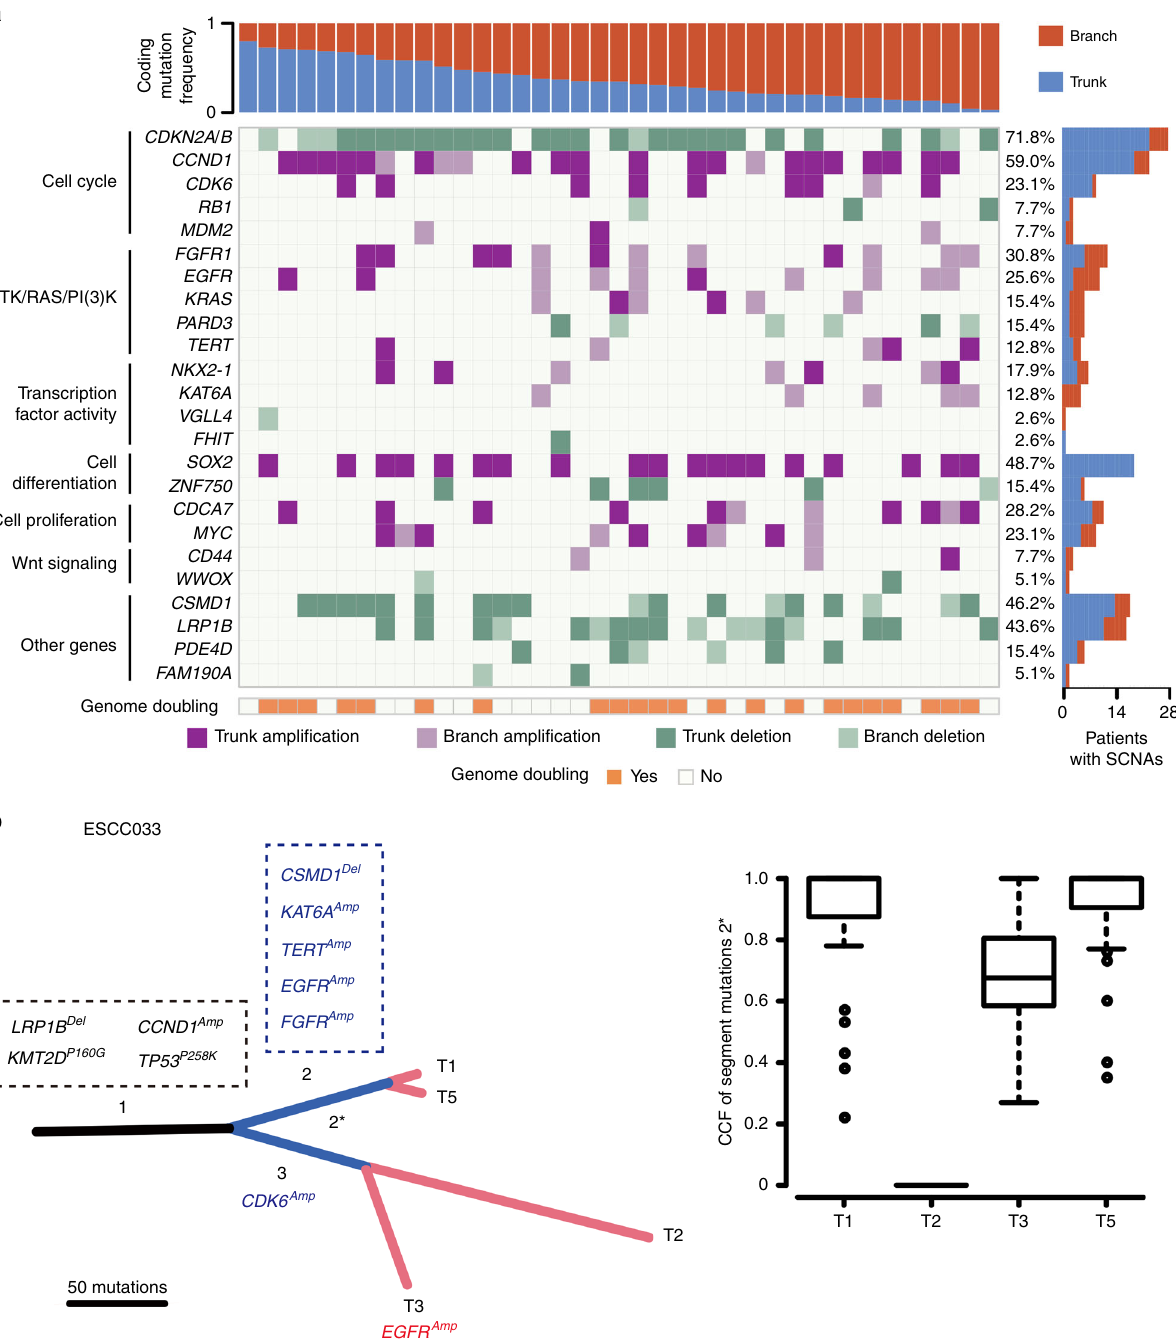
Fig. 2 Heterogeneity of ampli fi cation/deletion drivers in ESCC. a Heat map shows somatic CNAs with different clonal status. The right bar represents the proportion of identi fi ed as trunk/branch in ESCC; the bottom panel shows genome doubling status of each patient; the top panel shows the percentages of trunk or branch CNAs. b Clonal evolution in case ESCC033. The left panel shows phylogenetic tree based on somatic SNVs. Asterisk segments represent SNVs from intermixed clone; the right panel shows the CCF of segment mutation 2*. Black: trunk; blue: shared branches; red: private